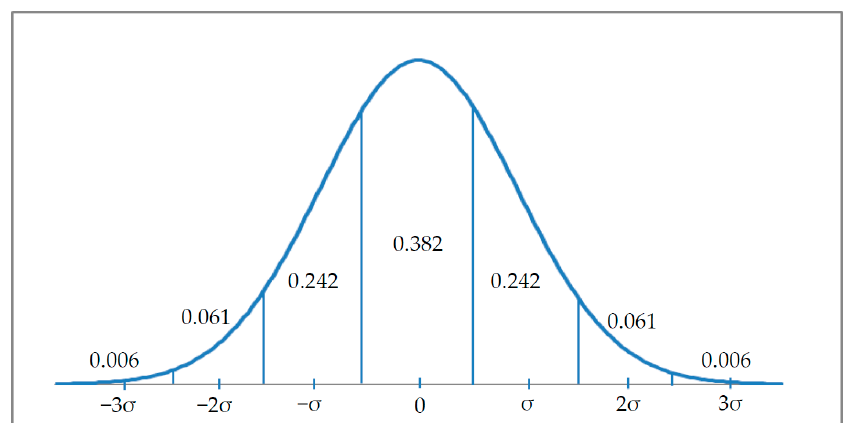
Figure 5. NLFE t distribution represented with a seven-step approximation.